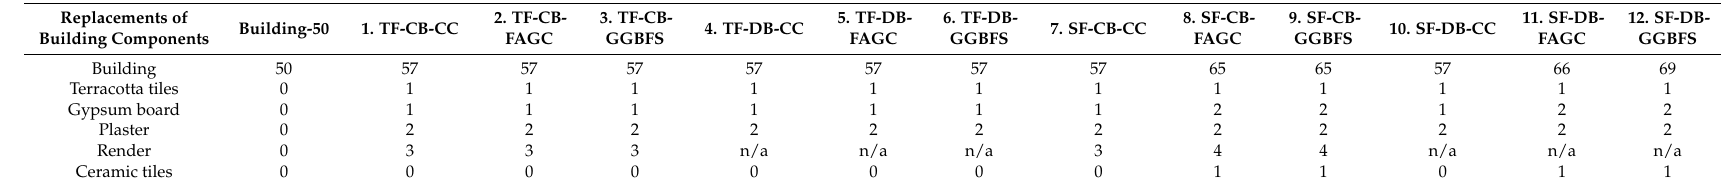
Table A6. Estimated number of replacements of building components in active service life of buildings.